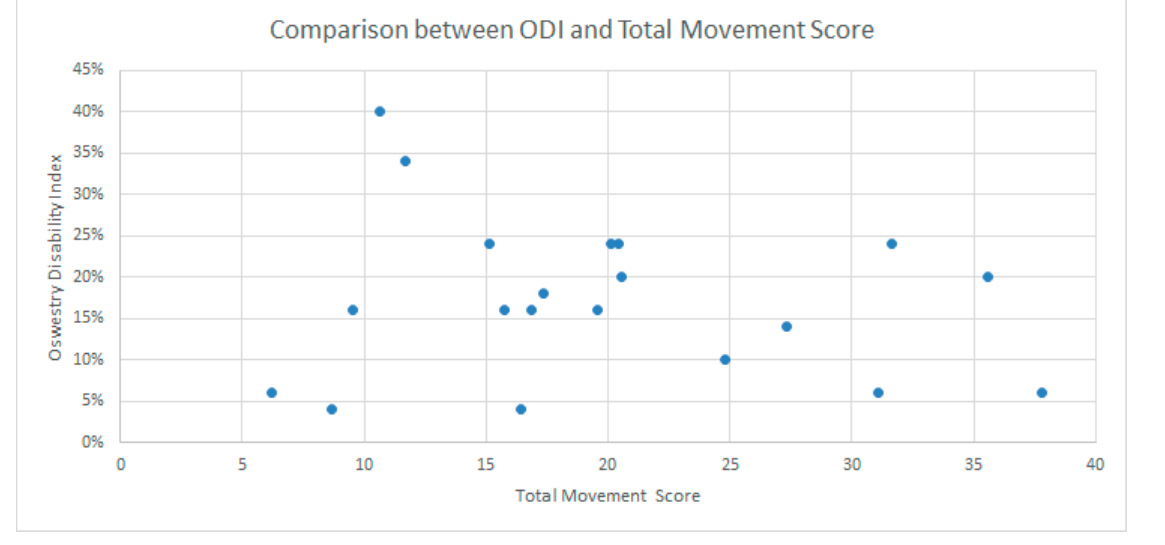
9 of 21 Table 5. Movement scores (overall and total) of participants with cLBP and healthy participants. cLBP T0